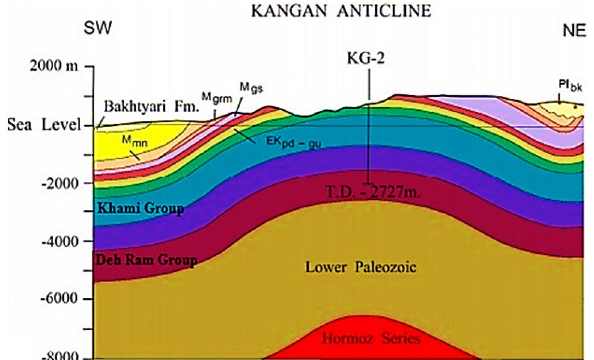
Fig. 3 The stratigraphic block diagram from the Kangan